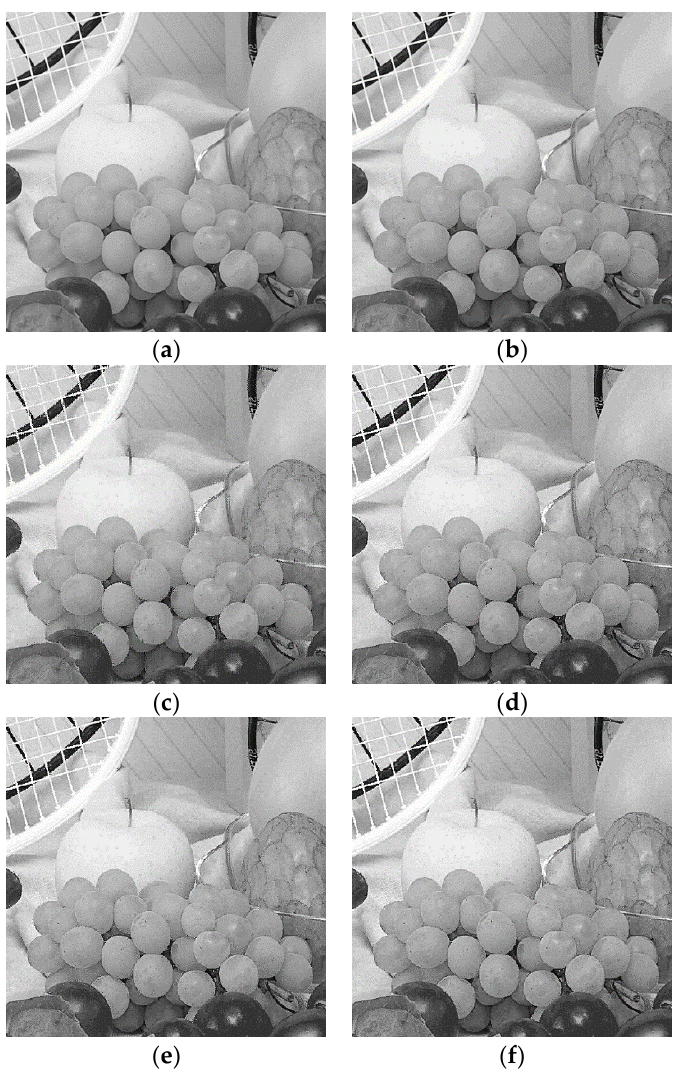
Figure 12. Visual investigation on Image Set 1 with quality factor 𝑄 = 8 : ( a ) input image; ( b ) JPEG decoded image; ( c ) ODBTC; ( d ) EDBTC; ( e ) DDBTC; and ( f ) DDBTC Gaussian method.